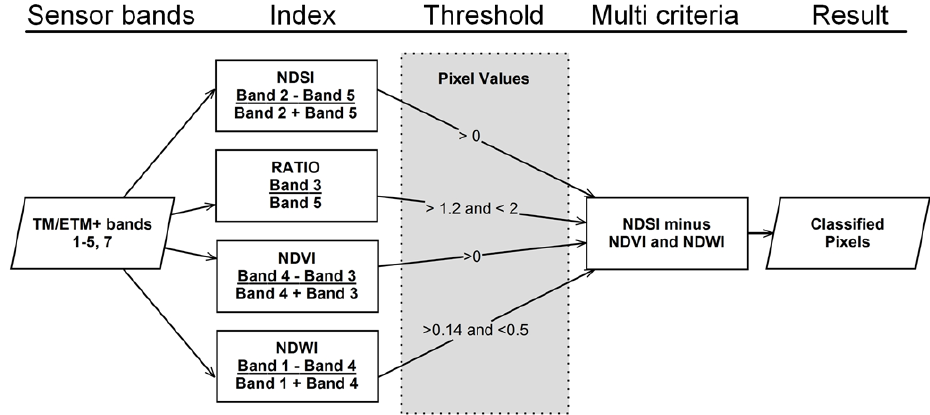
Fig. 2. An example of the multi-criteria analysis for the Landsat 5 TM and Landsat 7 ETM+ scenes. For the latter the corresponding values were 1999 NDSI > 0, NDWI > 0.16 and < 0.45, and NDVI < 0, and for 2011 NDSI > 0, NDWI > 0.15 and < 0.5, and NDVI < 0. Band ratios were the same for all scenes. The analysis was carried out using the tool BandMath in ENVI™